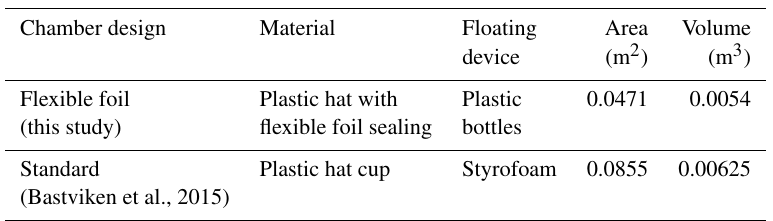
Figure 1. Two chamber designs: on (a) the standard chamber from Bastviken et al. (2015) and on (b) the flexible foil chamber (with a close-up of the peculiarity of the sealing). Table 1. Summary of the characteristics and geometrical properties of the two chambers.